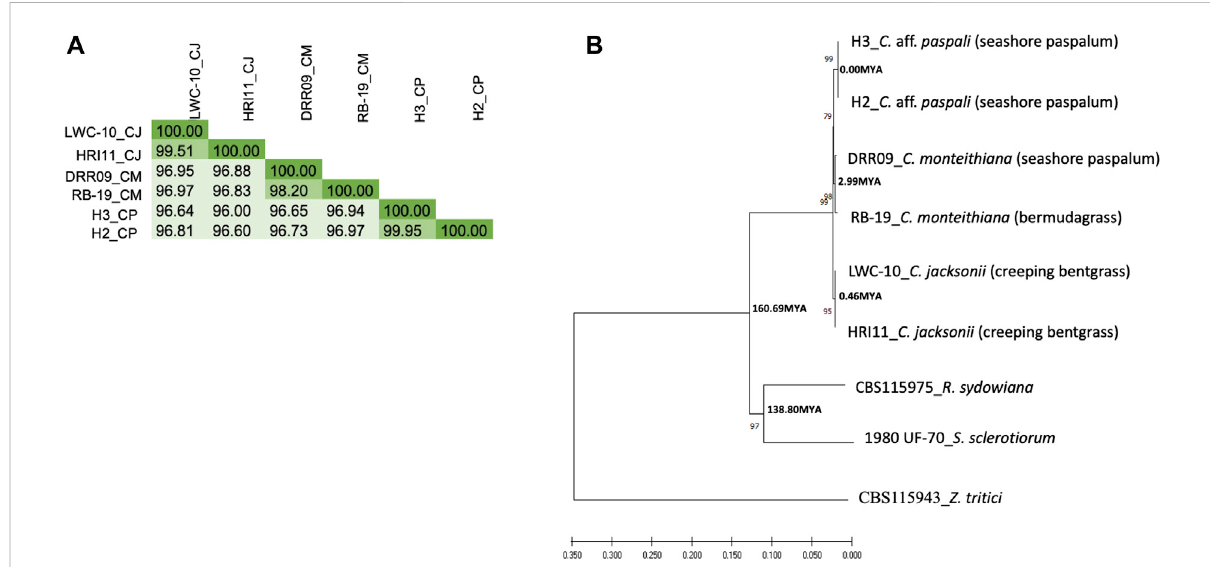
FIGURE 5 Genetic relationship of C. aff. paspali with related species. (A) DNA similarity matrix between the Clarireedia species. C. jacksonii (CJ), C. monteithiana (CM)and C. aff. paspali (CP)wererepresentedbyLWC-10andHRI11,DRR09andRB-19,H3andH2isolates,respectively. (B) Neighbor- joining tree of Clarireedia spp. and related species conducted from combined virulence and conserved gene sequences. Numbers associated with branches are bootstrap percentage. Two isolates for each Clarireedia species were used. S. sclerotiorum (1980 UF-70) and R. sydowiana (CBS115975) were used as representatives of the Sclerotiniaceae family and the Rutstroemiaceae family, respectively. Z. tritici (CBS115943) was used as an outgroup. Numbers associated with nodes are estimated divergence times. When known, the host origin of the isolate was indicated between